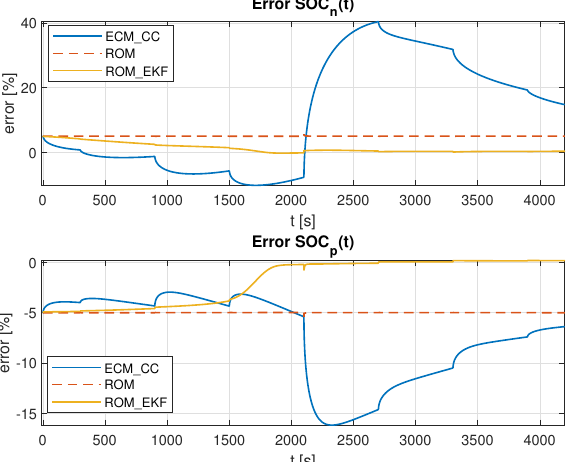
( t ) = [ 0.8,0.2 ] , SOC ∓ 0 NM